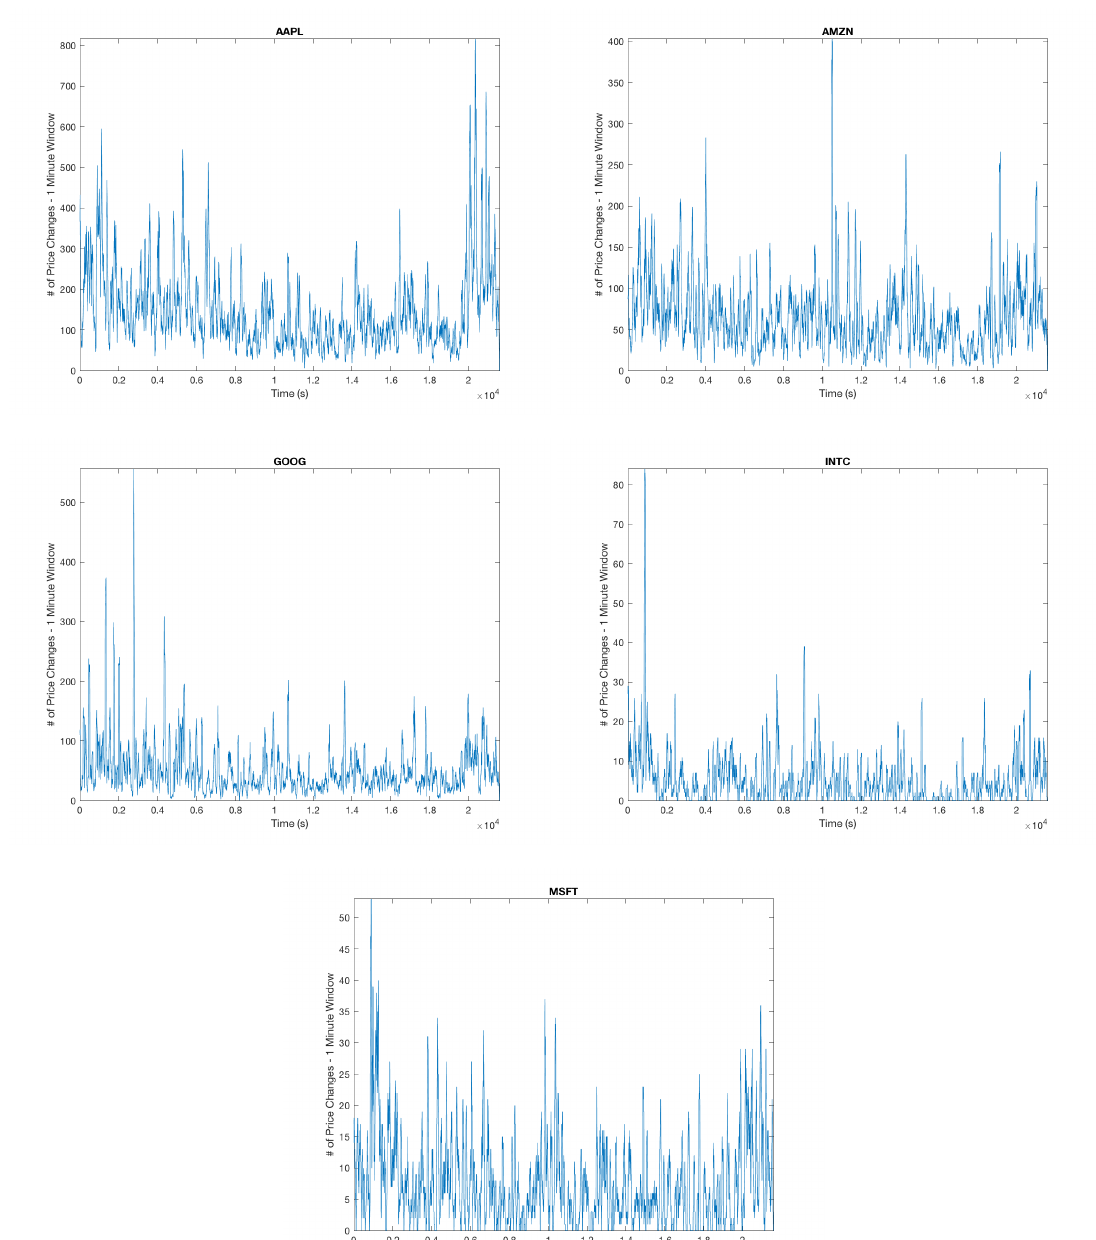
Figure 2. Each plot shows the number of arrivals for a moving one minute window. From this, we can conclude that there is a significant amount of clustering in the arrival of mid-price changes, motivating the Hawkes model of our arrival